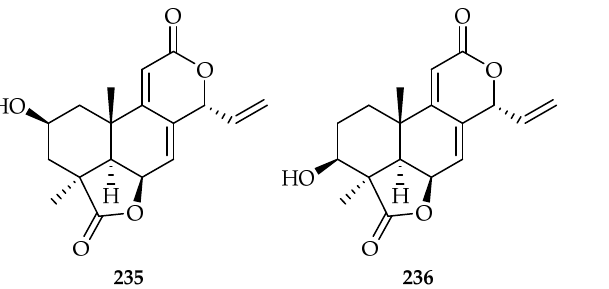
Figure 93. Structures of 2 β -hydroxymakilactone A 235 [146] and 3 β -hydroxymakilactone A 236 [146].